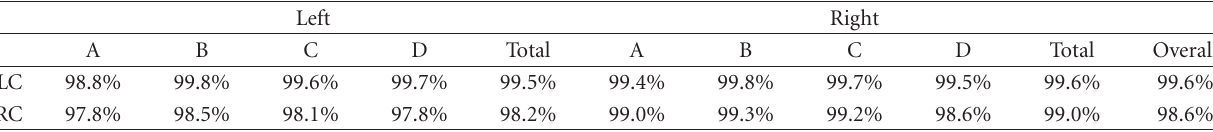
Table 1: True positive rate in TLC and FRC scans.